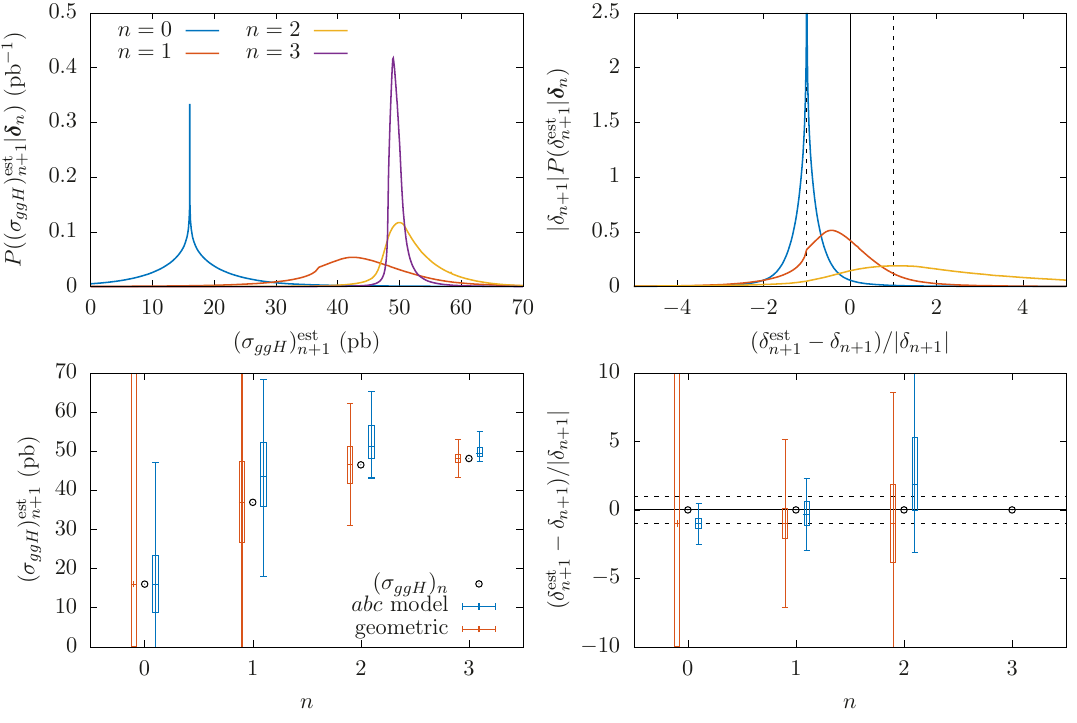
Figure 12 . Top left panel: the probability distributions from the abc -model for the inclusive gluon- fusion Higgs production cross-section ( σ values of n . Top right panel: the same distributions normalised to the exact N n +1 LO correction. Bottom left panel: the median (plus), 68% CI (errorbox) and 95% CI (errorbar) for the posterior of ( σ ) est , computed from the abc (blue) and geometric (red) models using information on the ggH n +1 previous orders. The exact values of ( σ scaled to the exact N n +1 LO